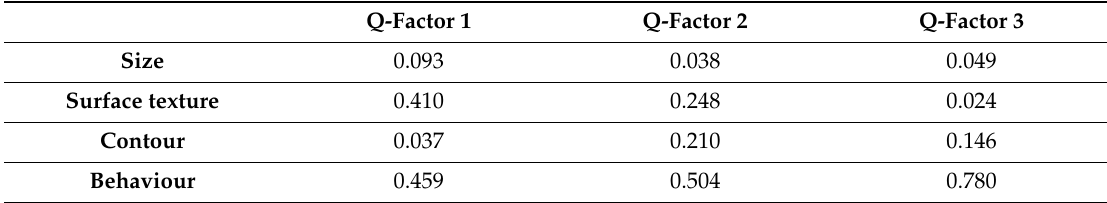
Table 2. Dominance weights of variables for each